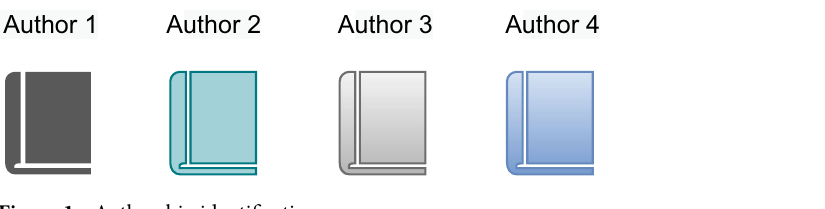
Figure 1. Authorship identification